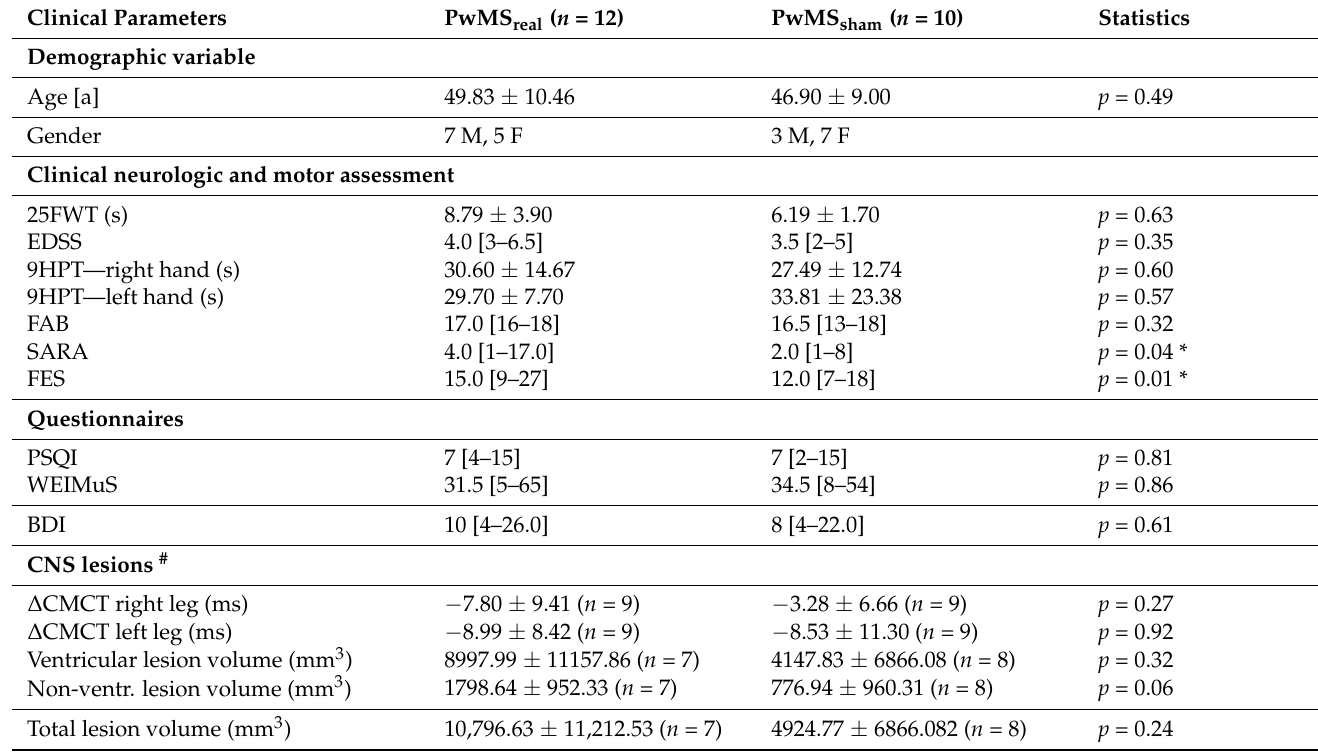
Table 1. Demographic, clinical, neurophysiological, and functional data are given for each group (PwMS real and PwMS sham ). Continuous data are expressed as mean ± standard deviation and ordinal data as median [range].